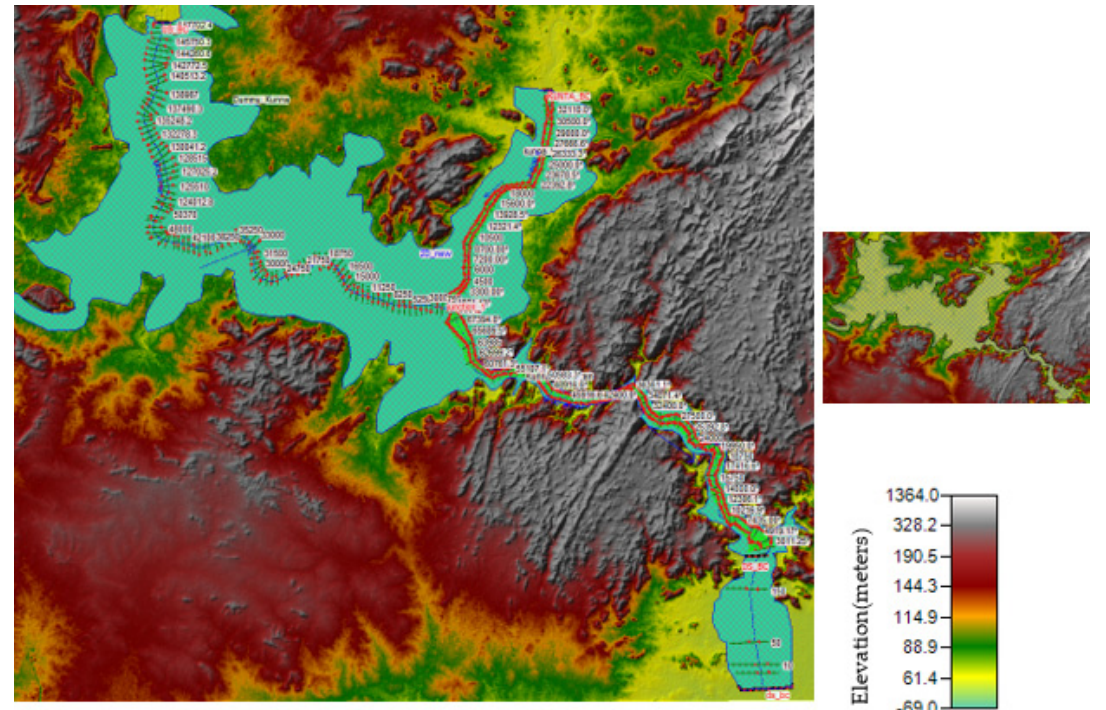
Figure 4. DEM (30 m × 30 m) map and cross-section data considered for the study.